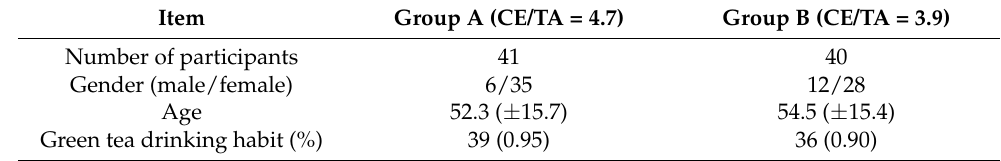
Table 2. Participants in the clinical